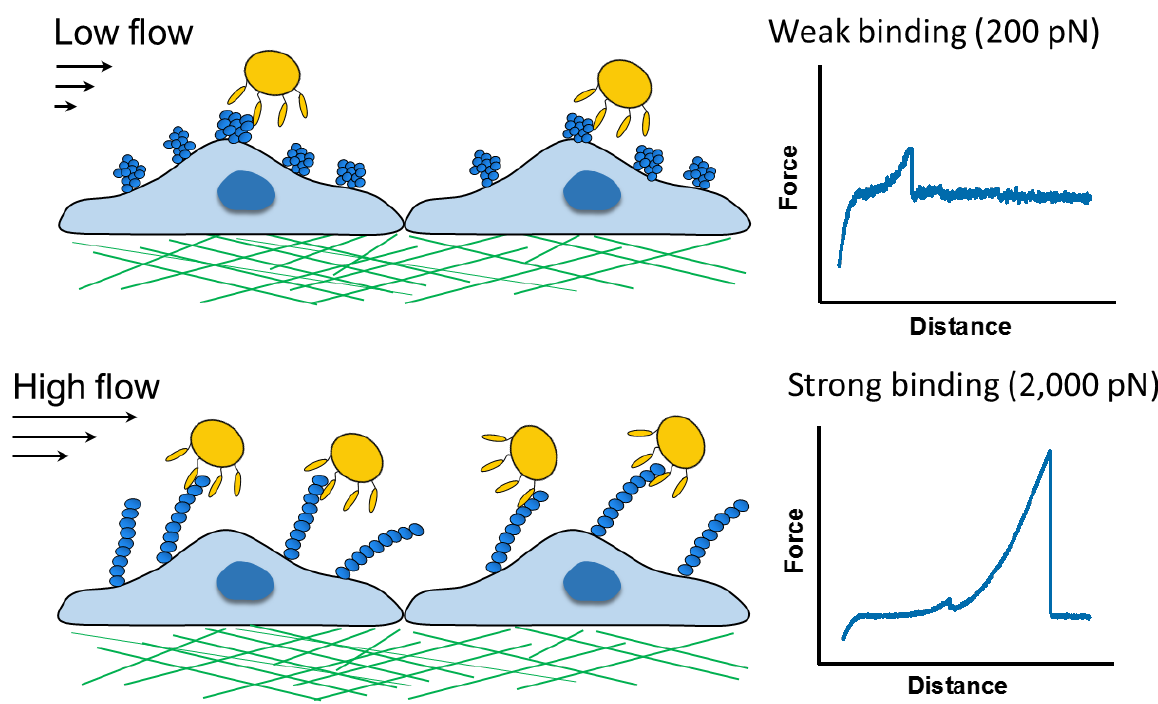
FIGURE 1: Force-induced activation of the SpA-vWF bond. Single-molecule pulling experiments led us to propose a mechanism whereby force-induced extension of vWF leads to the exposure of a cryptic binding site to which SpA proteins on the bacterial cell surface strongly bind. SpA-vWF bonds at high stress are much stronger (binding strength of  2,000 pN) than most receptor-ligand bonds measured to date, thus highlighting the importance of protein mechanobiology in bacterial